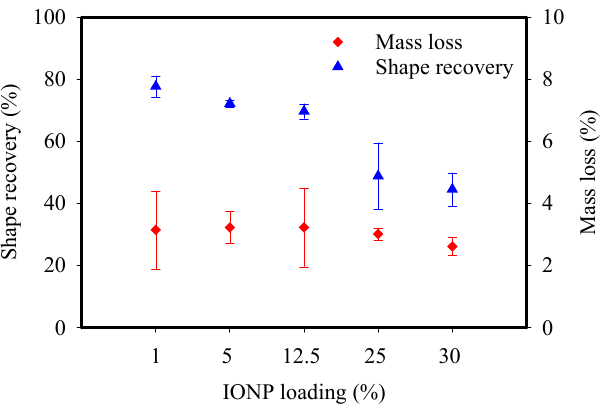
Figure 7. Shape recovery and mass loss of CNF-IONP aerogels at various IONP loadings. Error bars represent standard deviation from triplet measurements.